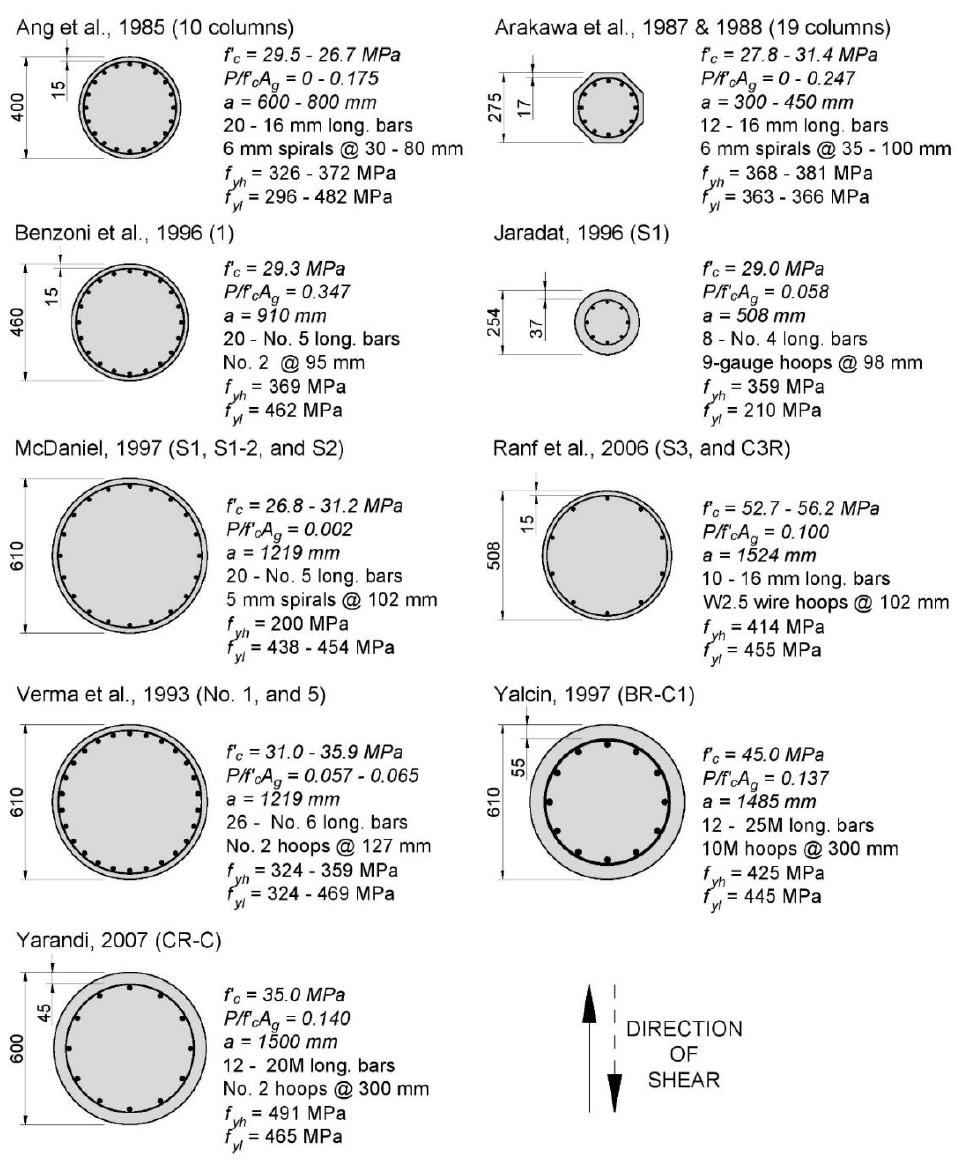
Figure 1. Shear-critical circular and octagonal columns investigated with reversed-cyclic shear applied in the direction as shown. Adapted from [6 – 10,19 – 24]. Table 1. Details of circular and octagonal columns and shear strength predictions using the AASHTO Simplified and General Procedures.